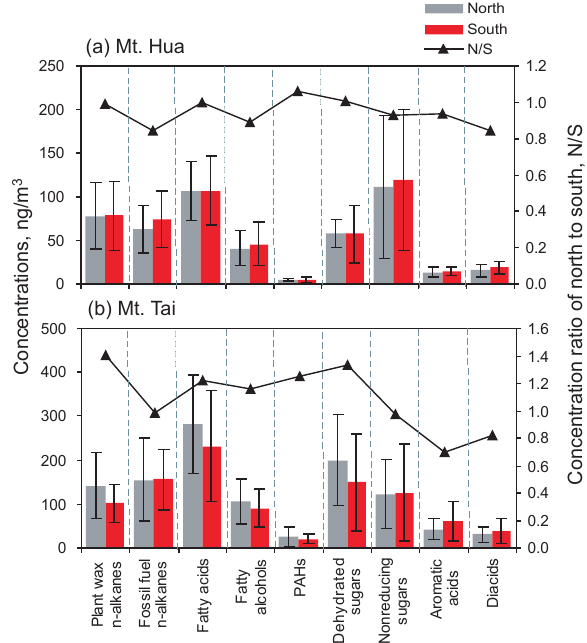
Figure. 8 Comparison of organic aerosols in PM10 from southerly air mass with those from the northerly Fig. 8. Comparison of organic aerosols in PM 10 from the southerly during the non-dust storm period.